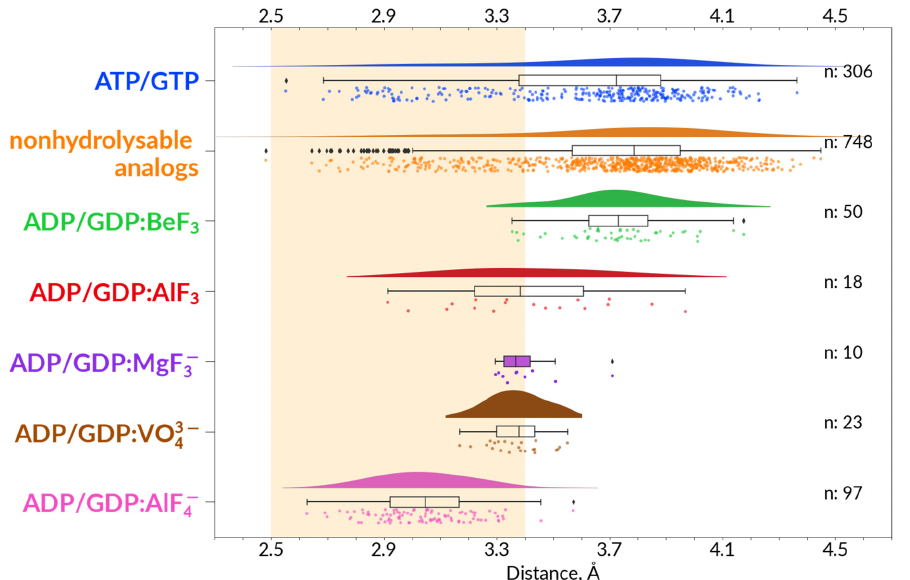
Figure 3. Distances between HN K − 3 and the O 2G atom or its analogue in the catalytic sites of P-loop fold NTPases. Data are shown only for structures with resolution ≤ 2.5 Å (see Table S1 for the whole data set). For each type of complex, distances are visualized as a kernel density estimate (KDE) plot, a box plot, and individual data points, each point representing one catalytic site in one structure. For ADP/GDP:MgF 3 − complexes, the density plot is not shown because of scarcity of data. The range of H-bond-compatible lengths is highlighted in